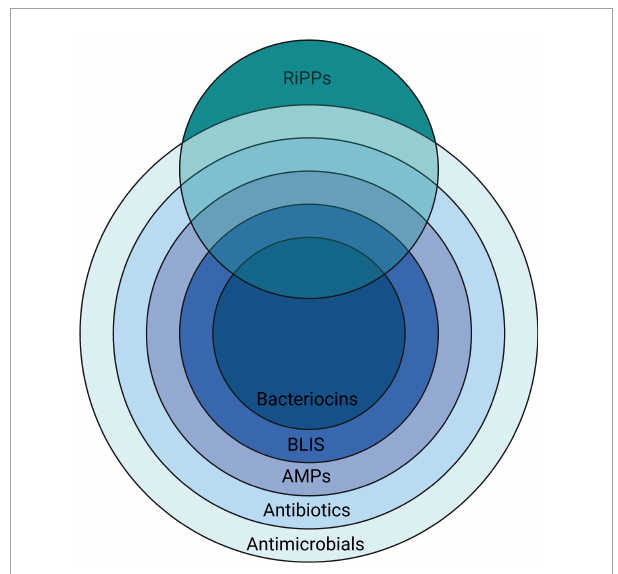
FIGURE1 A nested overview of the contemporary usage of the terms used to describe various chemical agents having activity against microorganisms, illustrating how they relate to the more broadly applicable terms antibiotics (literally “opposing life”–used for any substance active against microbes, but in current usage referring to naturally-produced agents) and antimicrobials—a term that is also inclusive of synthetic substances. Created with